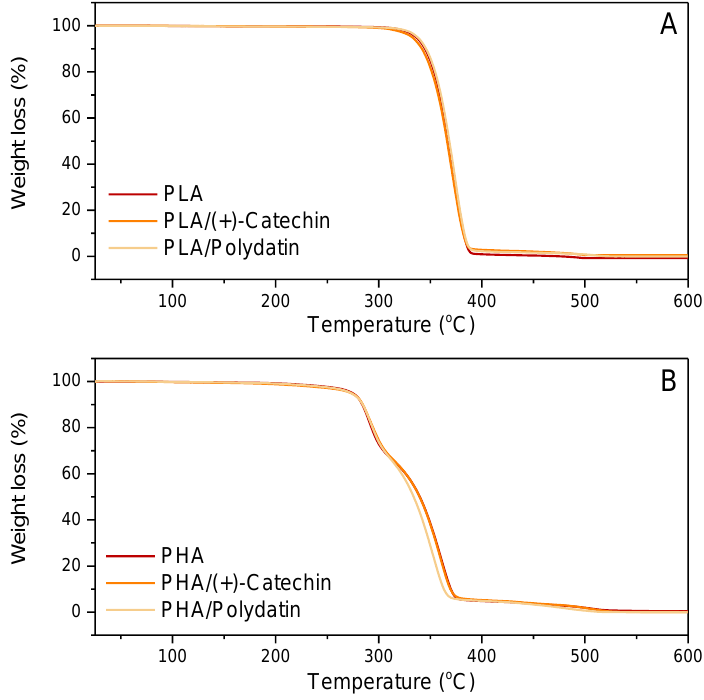
Figure 6. Thermal decomposition (TGA) curves of PLA ( A ) and PHA ( B ) samples.